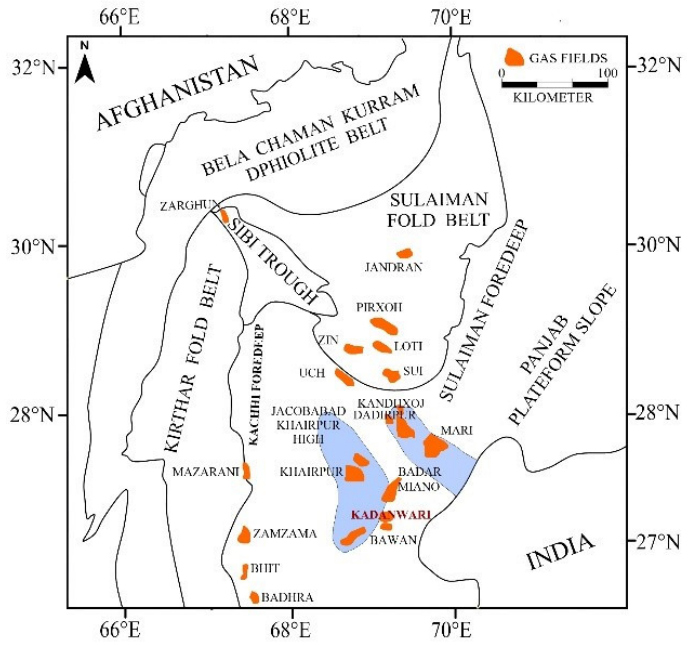
Figure 1. A regional geological map of Pakistan gas fields within the Middle Indus Basin, complete with the structural settings, tectonics, and local multi-sedimentary basins that are close to the Jacobabad-Khairpur High.